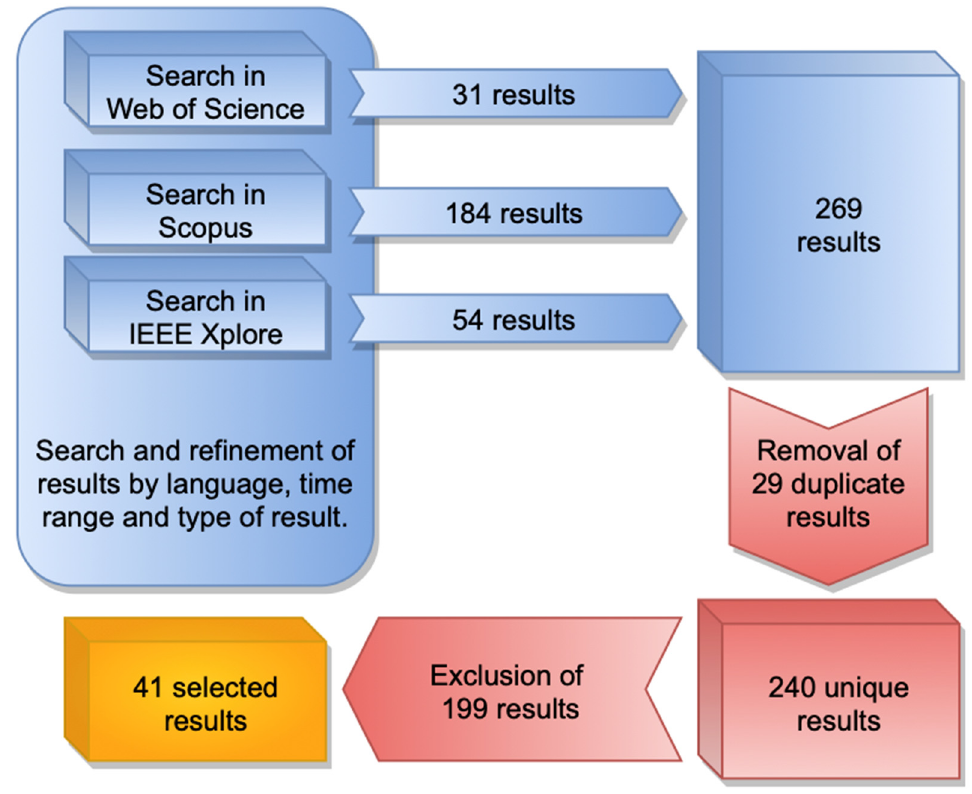
Figure 1. Illustrative diagram of the process followed for the selection of works.